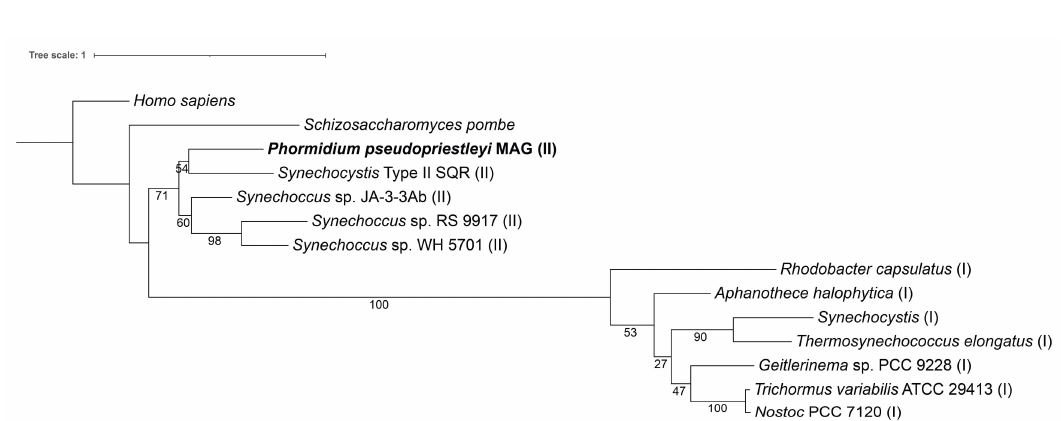
Figure 2. A maximum likelihood tree of type I and II SQR amino acid sequences from Shahak and Hauska, 2008. Homo sapiens (accession number AAH16836), Schizosaccharomyces pombe (accession number CAA21882), Phormidium